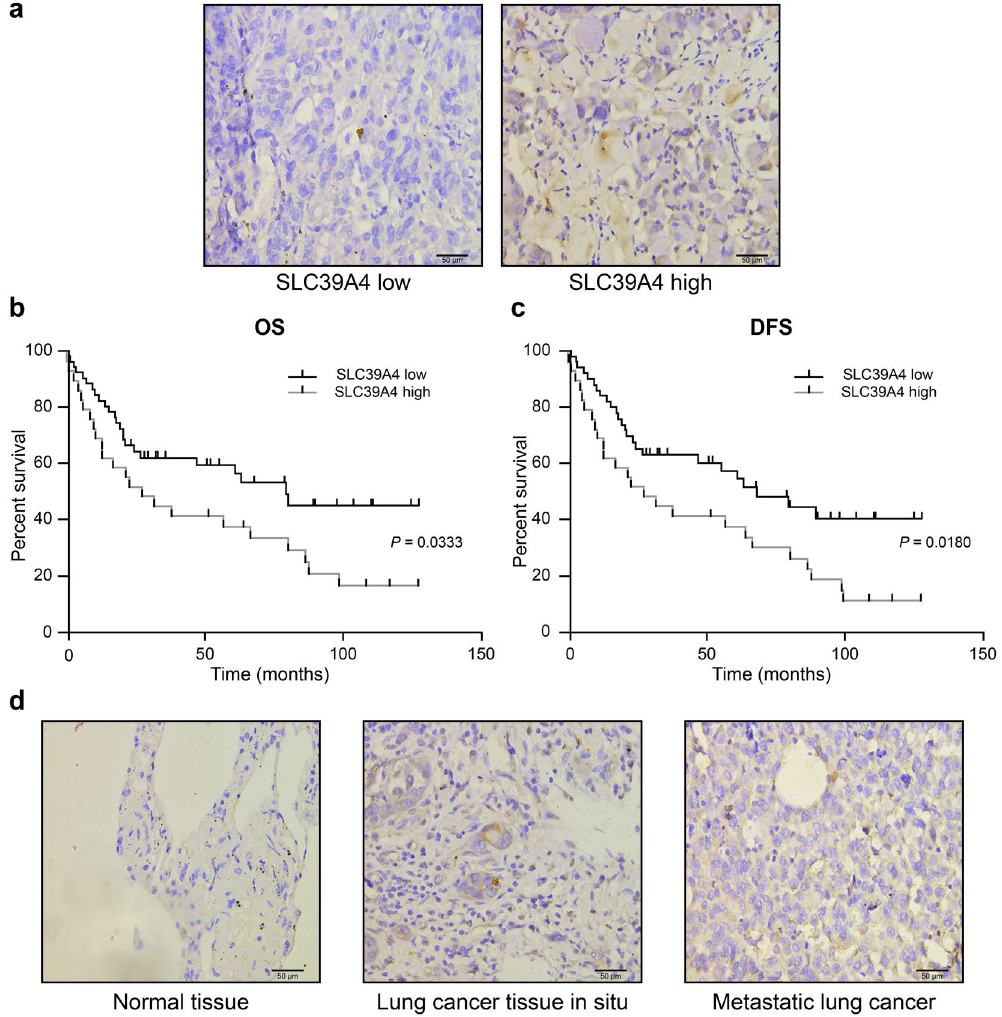
Figure 2. Kaplan-Meier analysis of association of SLC39A4 expression with patient survival. ( a ) Representative images of SLC39A4 low and SLC39A4 high samples (scale bar, 50 μ m). ( b , c ) Association between SLC39A4 expression and overall survival (OS, b ) and disease-free survival (DFS, c ) by Kaplan-Meier analysis. ( d ) SLC39A4 expression in normal tissue, lung cancer in situ , and metastatic lesions (scale bar, 50 μ